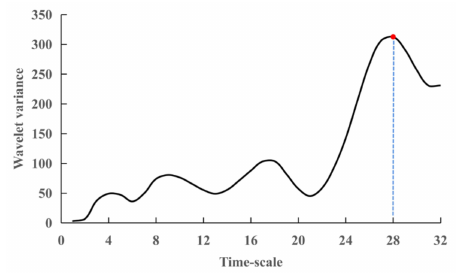
Figure 4. Runoff wavelet variogram.